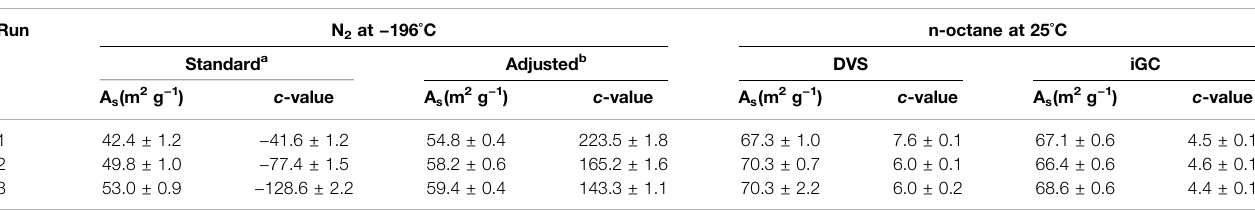
TABLE 1 | BET surface area (A s ) of freeze-dried BC calculated from various adsorption